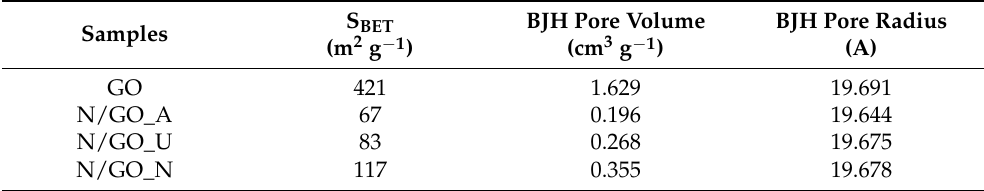
Table 4. Textural properties of nitrogen-doped graphene oxides.